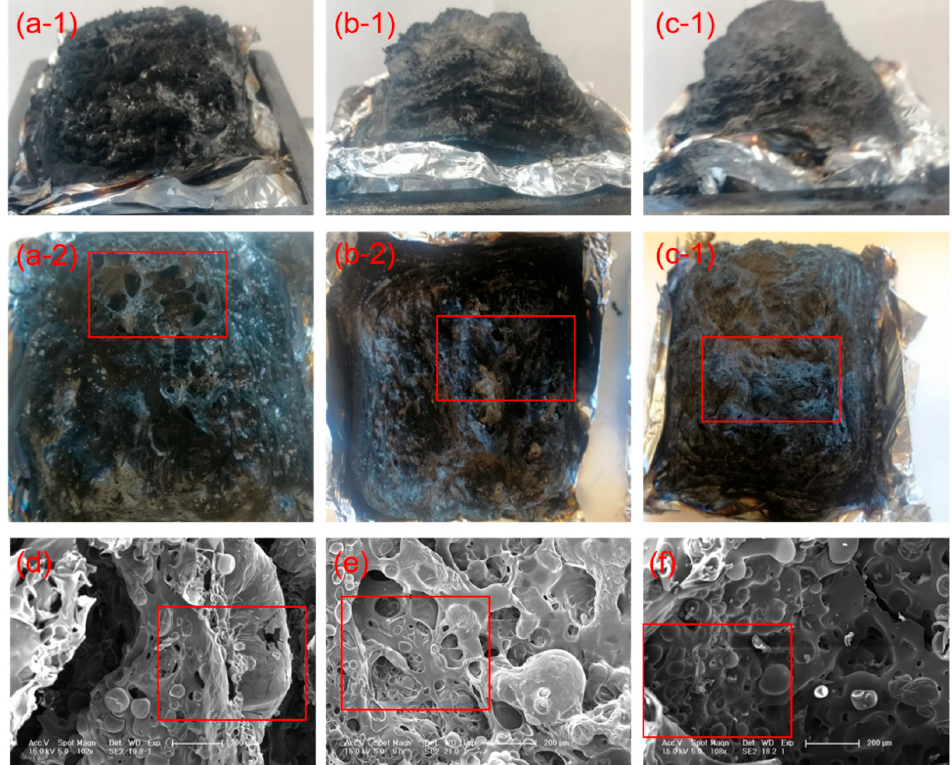
Figure 7. Digital images of chars from TPU/5%APP in top ( a-1 ) and front ( a-2 ) views, TPU/5%APP-Cu in top ( b-1 ) and front ( b-2 ) views and TPU/5%APP-Cu@PDA in top ( c-1 ) and front ( c-2 ) views, and SEM images of exterior chars from ( d ) TPU/5%APP, ( e ) TPU/5%APP-Cu, and ( f ) TPU/5%APP-Cu@PDA.